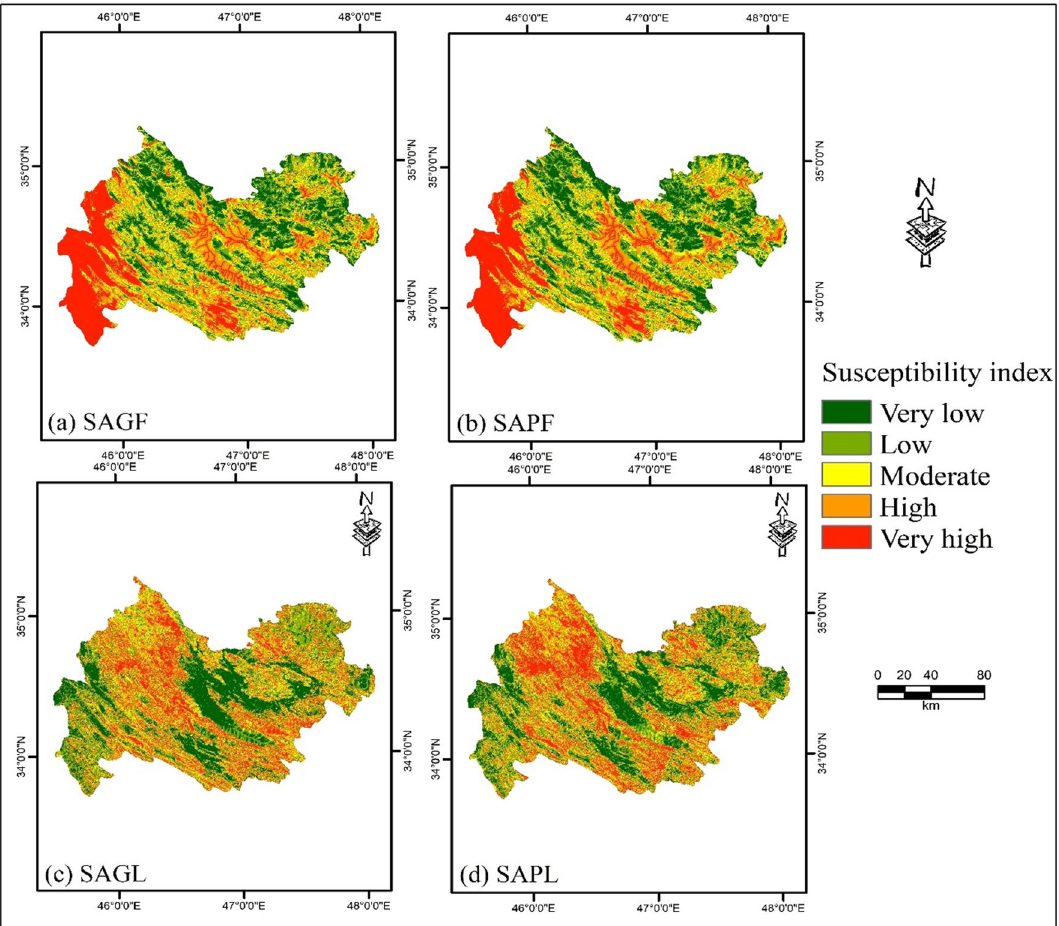
Figure 1. Natural hazard susceptibility maps generated by ( a ) SAGF, ( b ) SAPF, ( c ) SAGL, and ( d ) SAPL using ArcGIS 10.3.1 software (https:// www. esri.